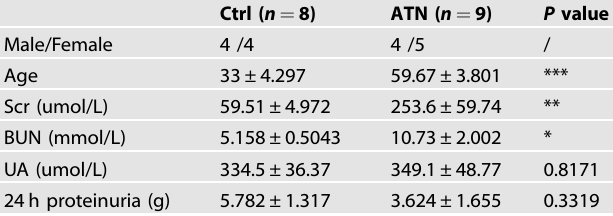
Ctrl control, patients with glomerular minor lesion were used as controls, ATN acute tubular necrosis, SCr serum creatinine; BUN blood urea nitrogen, UA uric acid. * p < 0.05, ** p <0.01, *** p <0.001 vs.